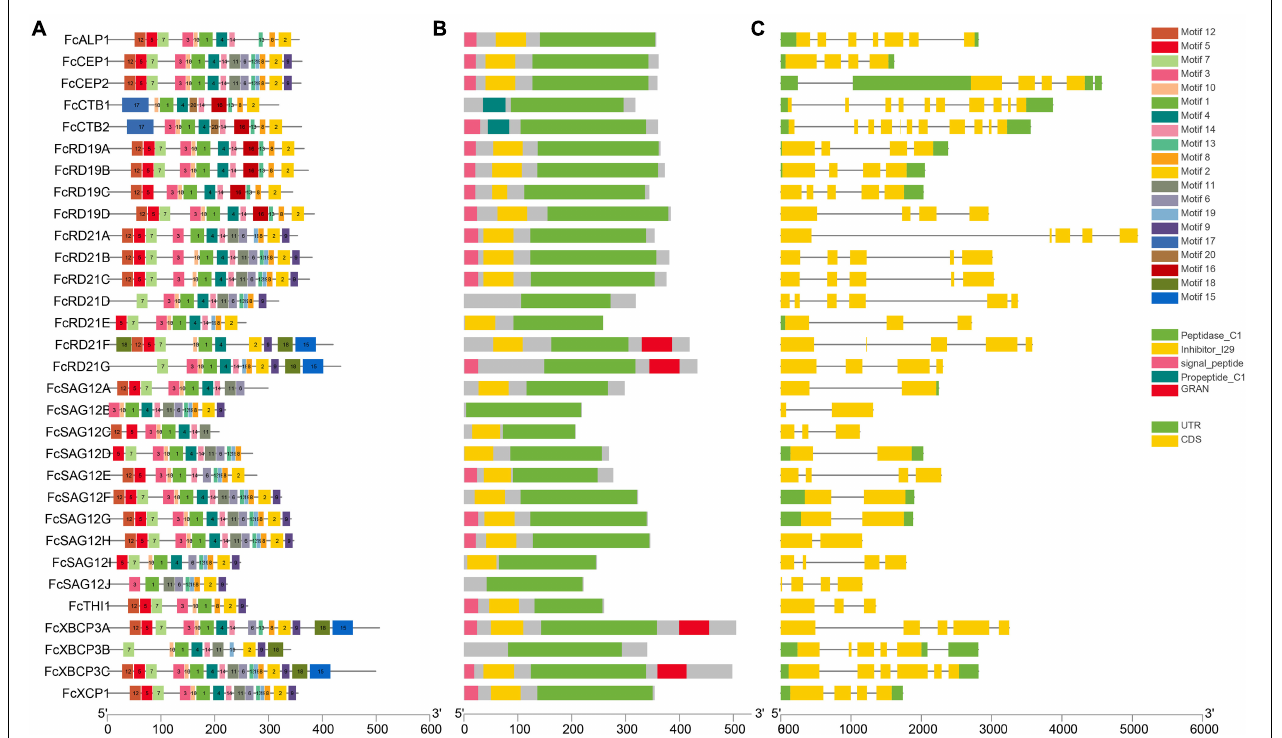
FIGURE 3 | Analysis of gene structure and conserved motifs of FcPLCP s. (A) Distribution of 20 conserved motifs of FcPLCP proteins. The conserved motifs are represented by different numbers and block colors. (B) Distribution of primary domains and signal peptides on FcPLCP proteins. (C) Graphic representation of exon–intron